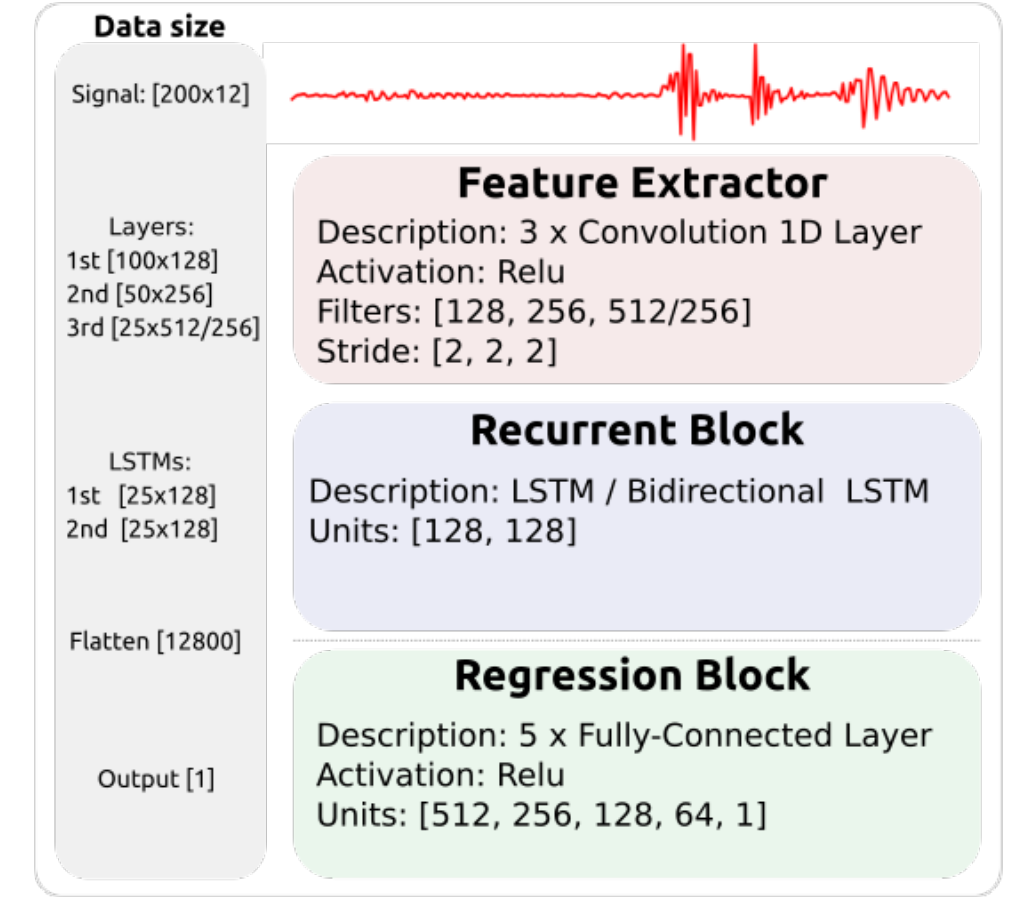
Figure 5. In our networks, the Feature Extractor produced high-level features from an input using 1D convolutions. In the ConvBiLSTMNet and the ConvLSTMNet, the Recurrent Block processed these features to find relevant connections for the stiffness estimation. However, in the former architecture it was done in the forward and backward manner (from the beginning of the signal and back). Finally, the Regression Block transformed high-level features into one scalar value. In our experiments, we exploited three architectures of neural networks. The difference is in the Recurrent Block—both recurrent NNs have the reduced number of filters in the last convolutional layer and added LSTM cells with 256 units (2 × 128), while in the ConvNet the output from the Feature Extractor is passed directly to the Regression